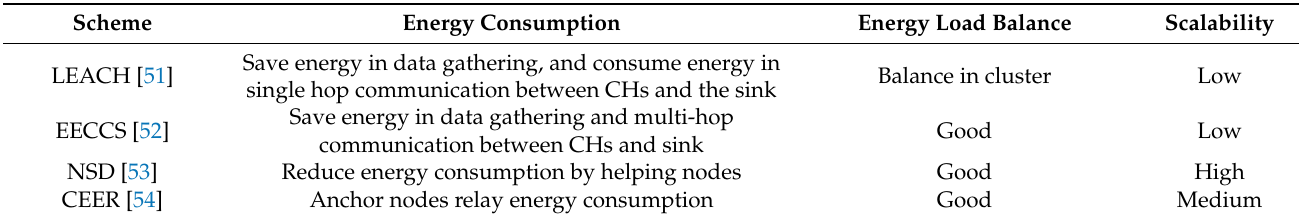
Table 1. Comparison of setting special node-based routing